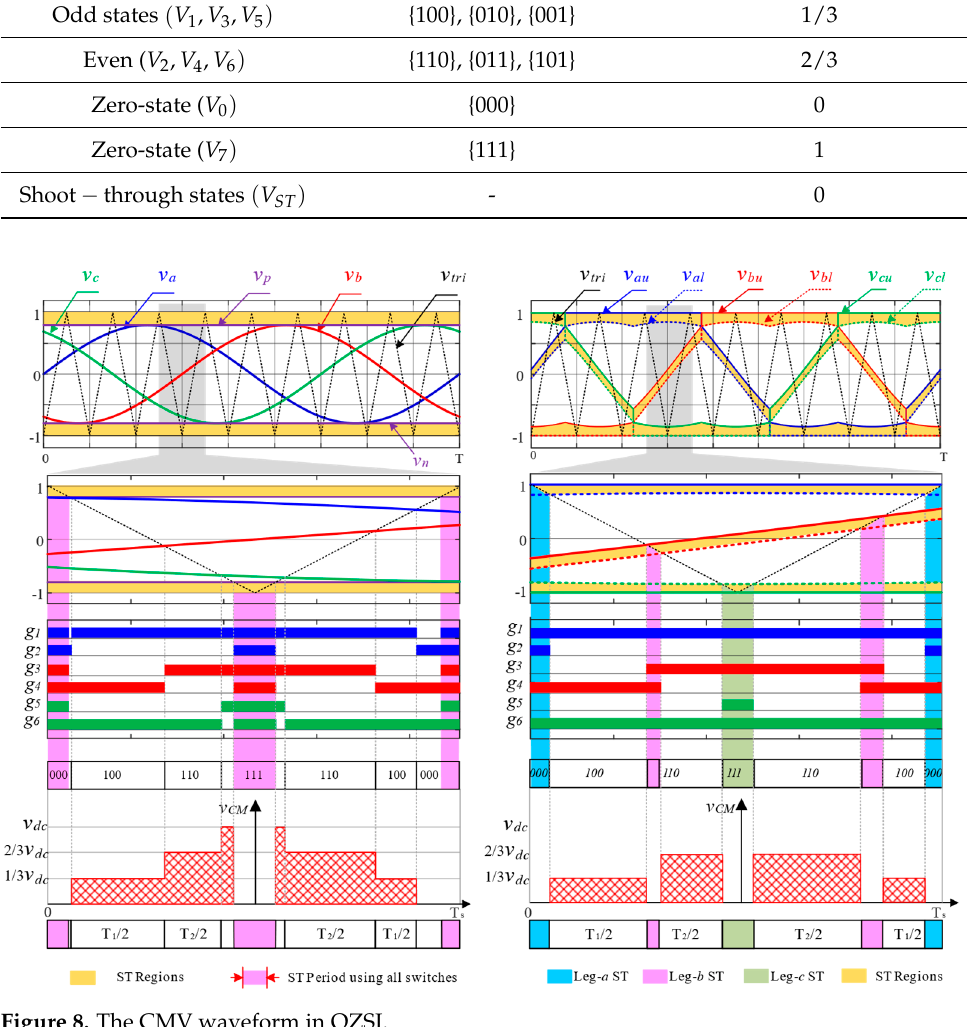
Figure 9. CMV waveforms during a carrier wave. ( a ) 3 Φ /SB/SPWM, ( b ) 3 Φ /MB/SPWM, ( c ) 3 Φ /SB/+DCCM, ( d ) 3 Φ /SB/-DCCM, ( e ) 3 Φ /MB/+DCCM, and ( f ) 3 Φ /MB/-DCCM